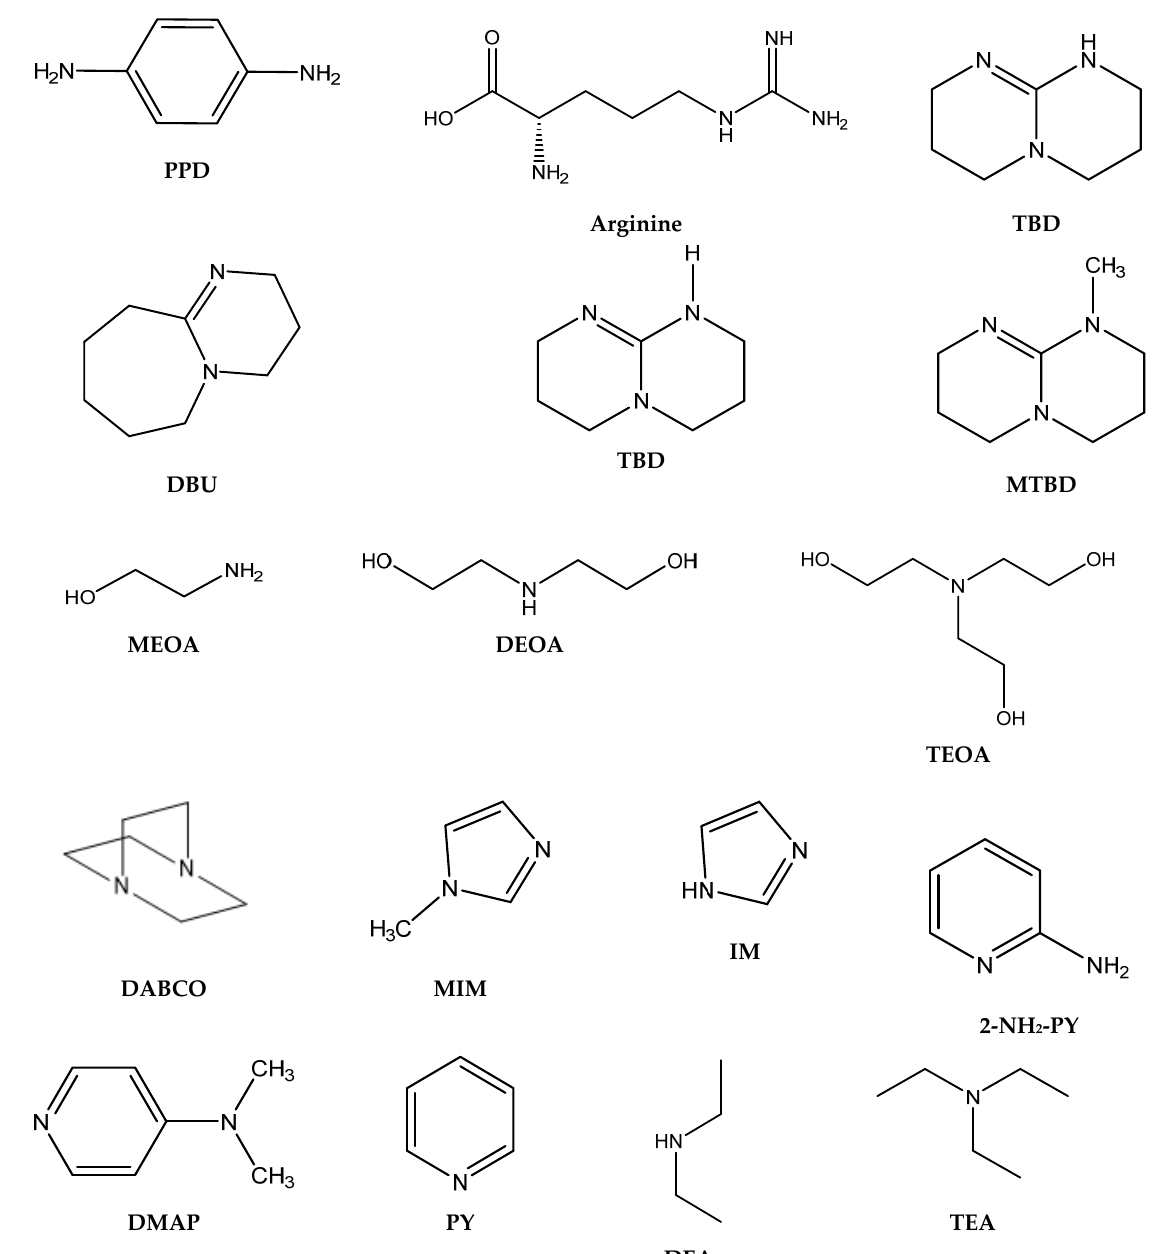
Figure 2. Structures and abbreviations of the tested amines.